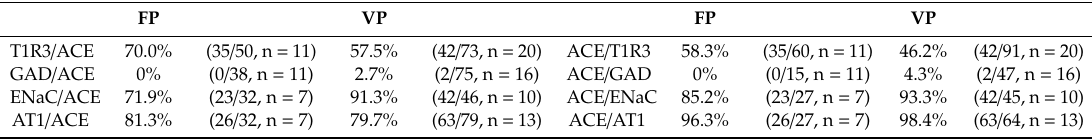
Table 2. Co-expression ratio of ACE1 and taste cell markers in fungiform (FP) and circumvallate papillae (VP) in mice. FP VP